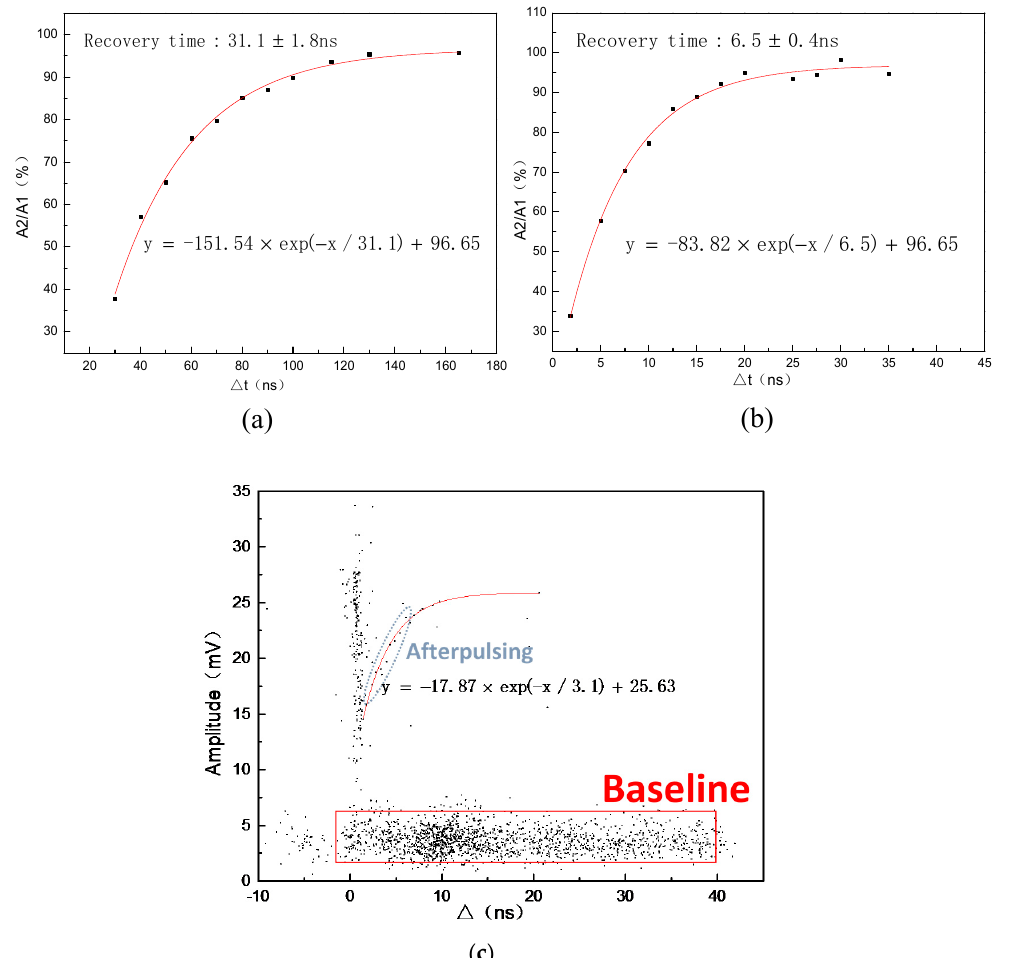
Figure 4. The recovery curve of 3 × 3 mm 2 EQR SiPM. ( a ) overall recovery time of the device is 31 ns when total 90,000 pixels were fired; ( b ) partial recovery time of the device is 6 ns when the number of fired pixels were controlled to be about 2000; ( c ) is the time-amplitude distribution of the afterpulsing, the recovery time of APD cell was fitted about 3.1 ns. (a,b) adopted double light pulse method; ( c ) adopted waveform analysis method.